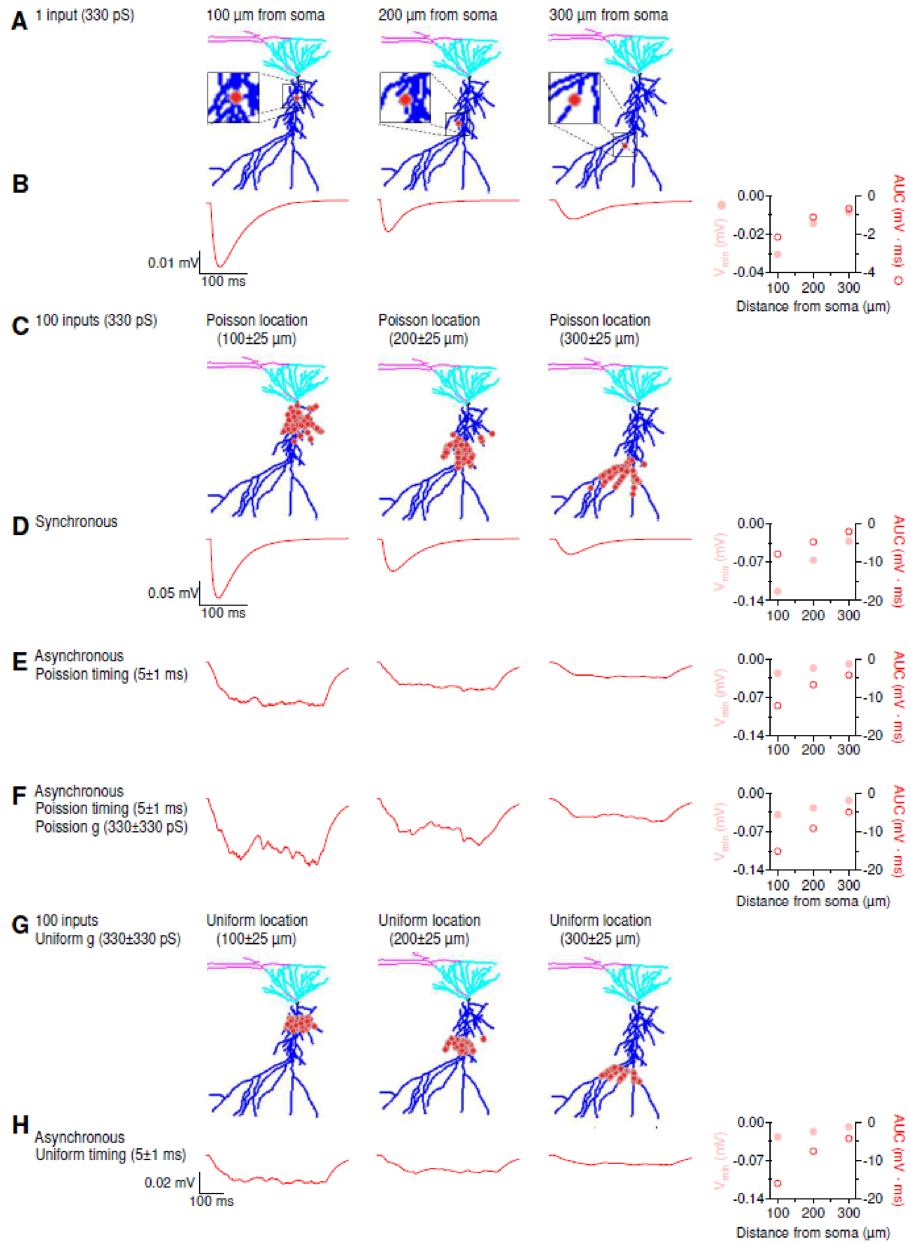
Figure 5. Sample Application of NRN-EZ for summation of IPSPs. ( A ) We used NRN-EZ to place one GABA A inhibitory input at 100–300 µm from the soma of a 3D reconstructed, biocytin-filled CA1-PCs. The maximum intensity projection of the CA1-PC includes the soma ( black ), basal dendrites ( cyan ), apical dendrites ( blue ) and the location of the input ( red ). The synaptic weight was set to 330 pS. ( B ) Somatic recording obtained using the NEURON simulation environment. The minimum value of the membrane potential (V min ) and the AUC of the somatic IPSP for increasing distances from the soma are plotted in the right panel. ( C ) As in A, for 100 inputs with a Poisson placement along the distal dendrite of the CA1-PC. ( D ) As in B, in response to the synchronous activation of the 100 inputs described in C. ( E ) Somatic IPSPs recorded in response to the asynchronous activation of the 100 inhibitory inputs described in C. ( F ) As in E, for synaptic inputs with a Poisson conductance distribution. ( G ) As in C, for 100 inputs with a uniform spatial distribution centered 100–300 µm away from the soma. ( H ) As in F, for 100 inputs with uniform spatial distribution and uniform timing of